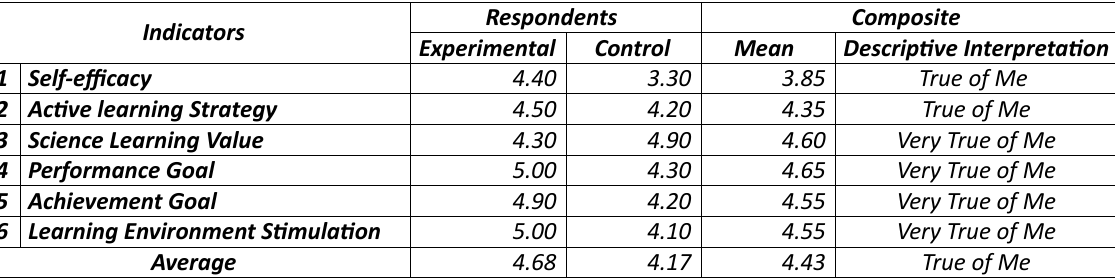
Table 3. The Students’ Motvaton in Learning Science